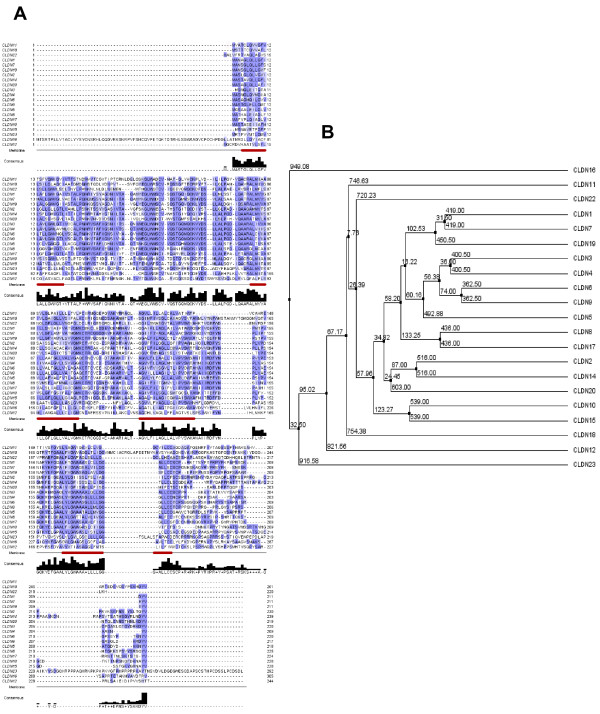
Multiple alignment and family tree of claudin proteins. A. ClustalW was used to generate alignment of all the human claudin protein sequences and the residues were then colored using Jalview [21] according to amino acid conservation among family members. Red bars underneath alignment indicate predicted transmembrane domains. The level of conservation and the consensus are also shown below the alignment. B. Phylogenetic tree of claudin family members. The tree was generated using ClustalW and visualize in Jalview. The numbers on the branches are Blosum62 scores, indicating distances among family members.